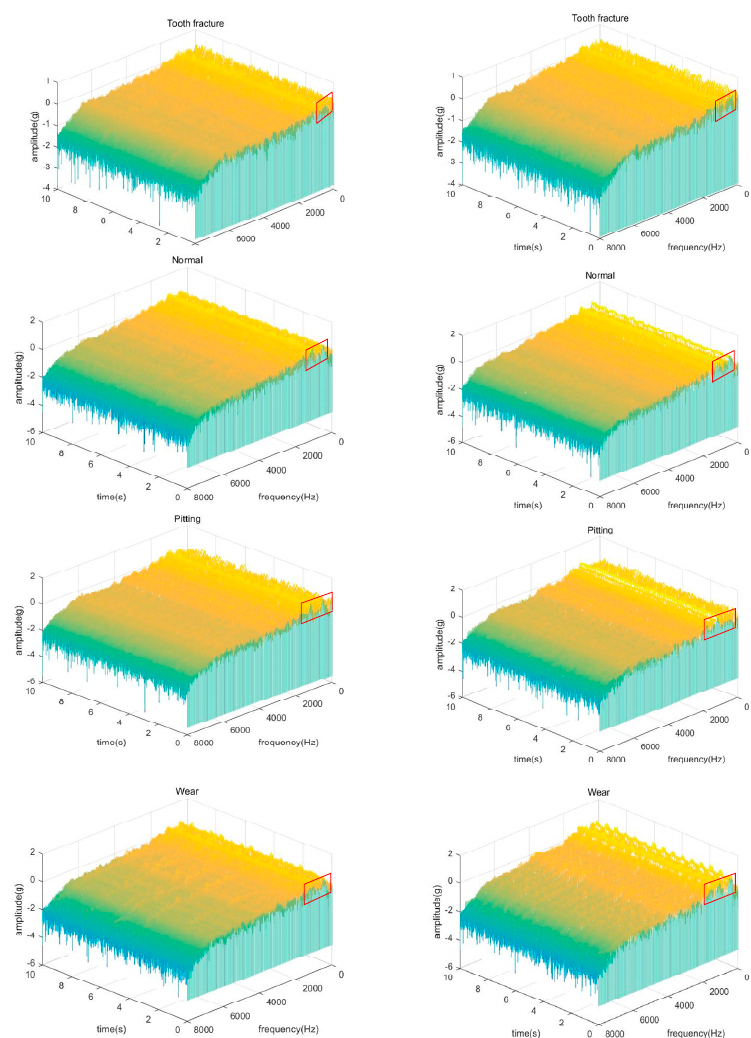
Figure 8 . Waterfall diagrams of four different types of gears under two-load conditions. ( A ) Represents a no-load condition and ( B ) represents a load